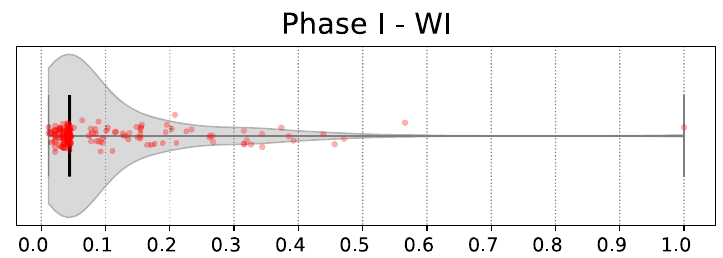
Figure 4: WI distribution of Dunaújváros Phase I ( c. 2200 – 1950 BCE ) . Bold black bar indicates the